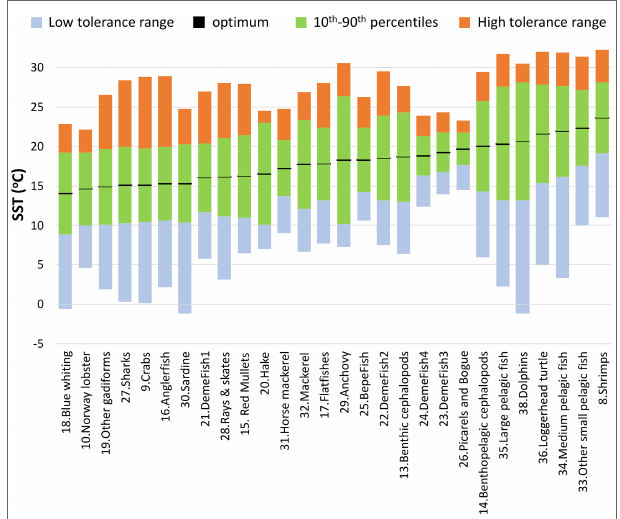
FIGURE 3 | Optimum temperatures (black lines), 10 th – 90 th preference range (green bars), lower tolerance range (blue bars) and higher tolerance range (orange bars) that were used to parameterize thermal responses for each FG in the Ecosim model. FGs are ranked by increasing optimal